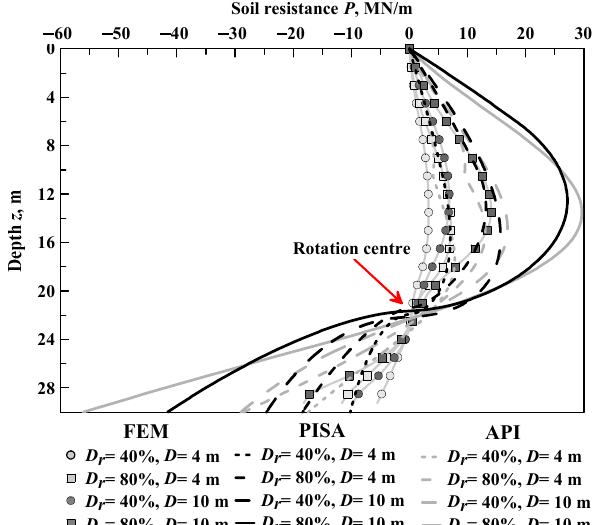
Figure 18. Soil resistance profiles in 40% and 80% relative density sands under a loading eccentricity of 5 m.